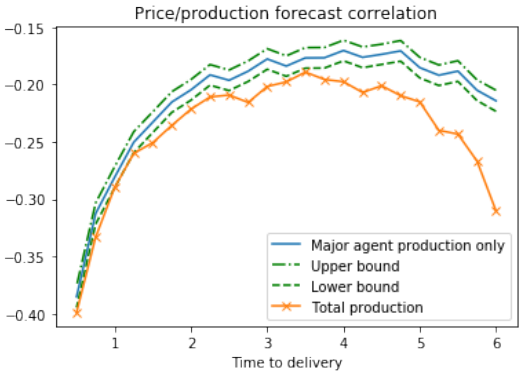
Figure 3. Correlation between the price increments and the major player renewable production increments vs. the correlation between the price increments and the total renewable production